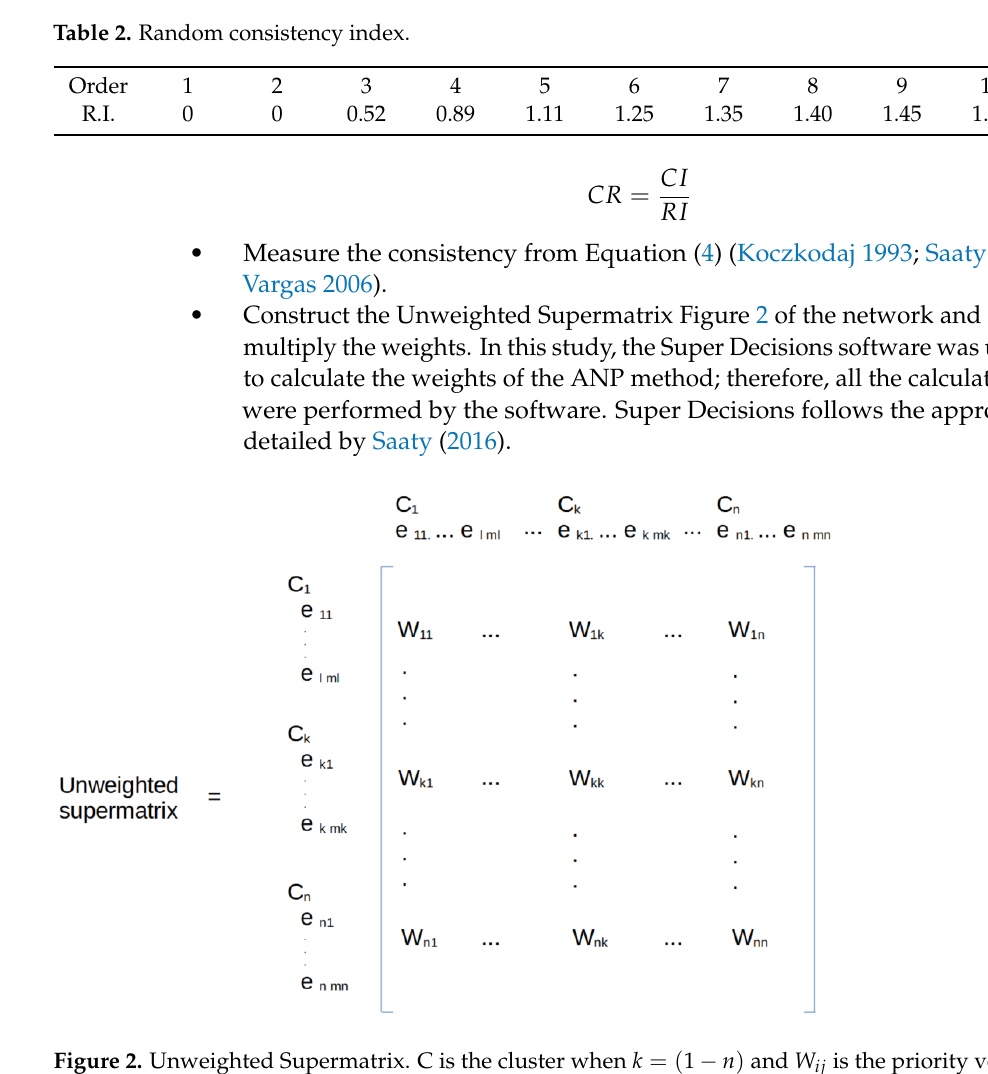
Figure 2. Unweighted Supermatrix. C is the cluster when k = ( 1 − n ) and W ij is the priority vector extracted from pairwise